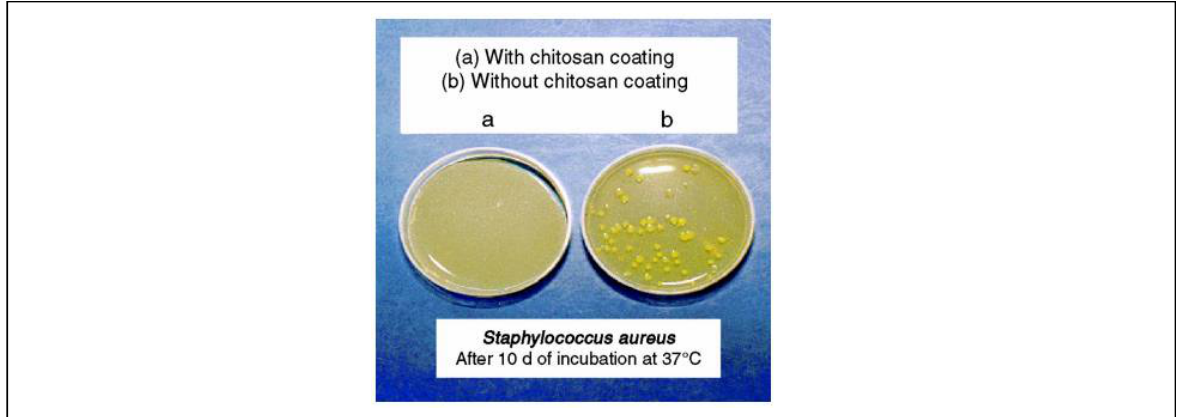
Figure 7: Development of Staphylococcus aureus inoculated on agar plate after 10 days of incubation at 37 °C (a) with chitosan coating and (b) without chitosan coating. Retrieved from Coma et al., 2003